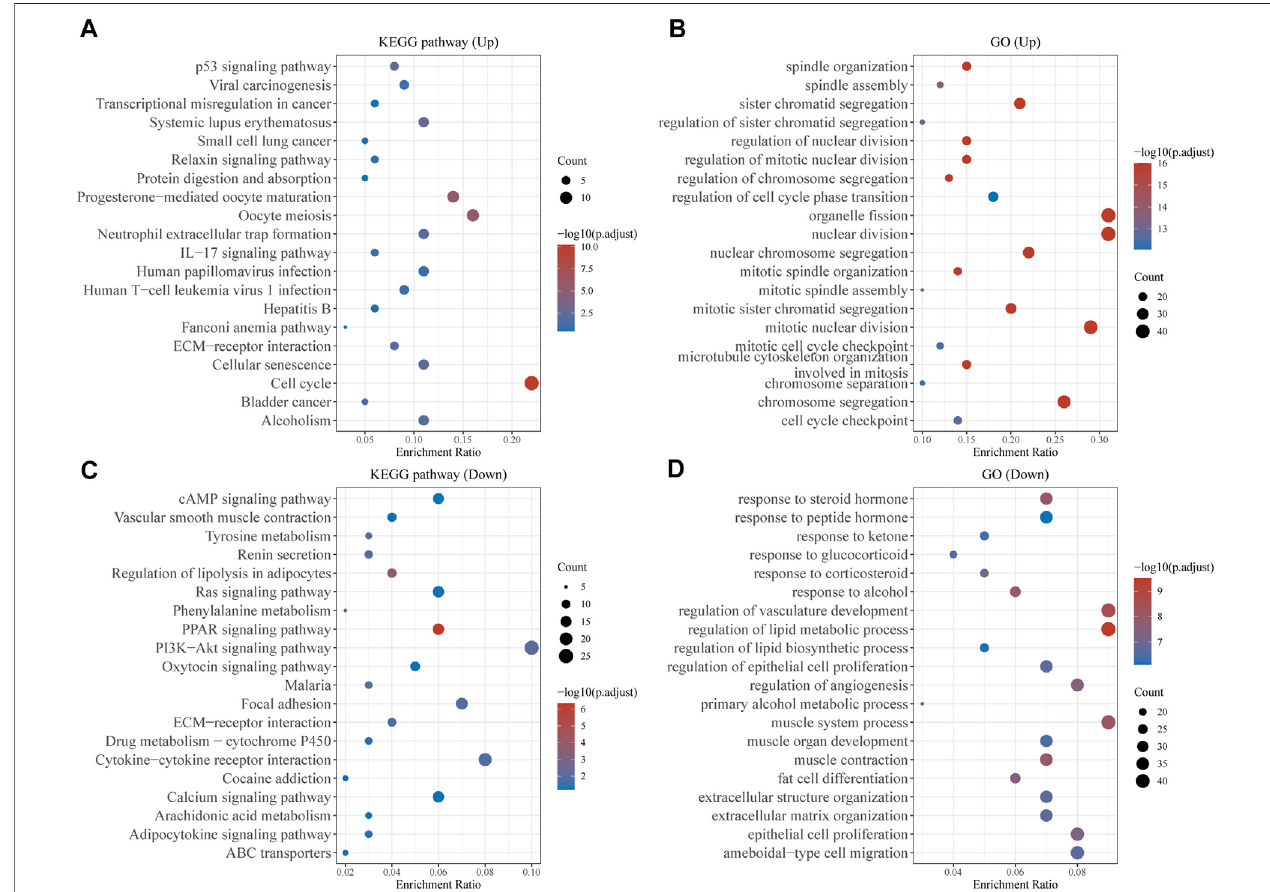
FIGURE 2 | Function Enrichment Analysis of DEGs. (A,B) KEGG and G Analysis of 140 upregulated genes in BC. (C,D) KEGG and G Analysis of 513 down- regulated genes in